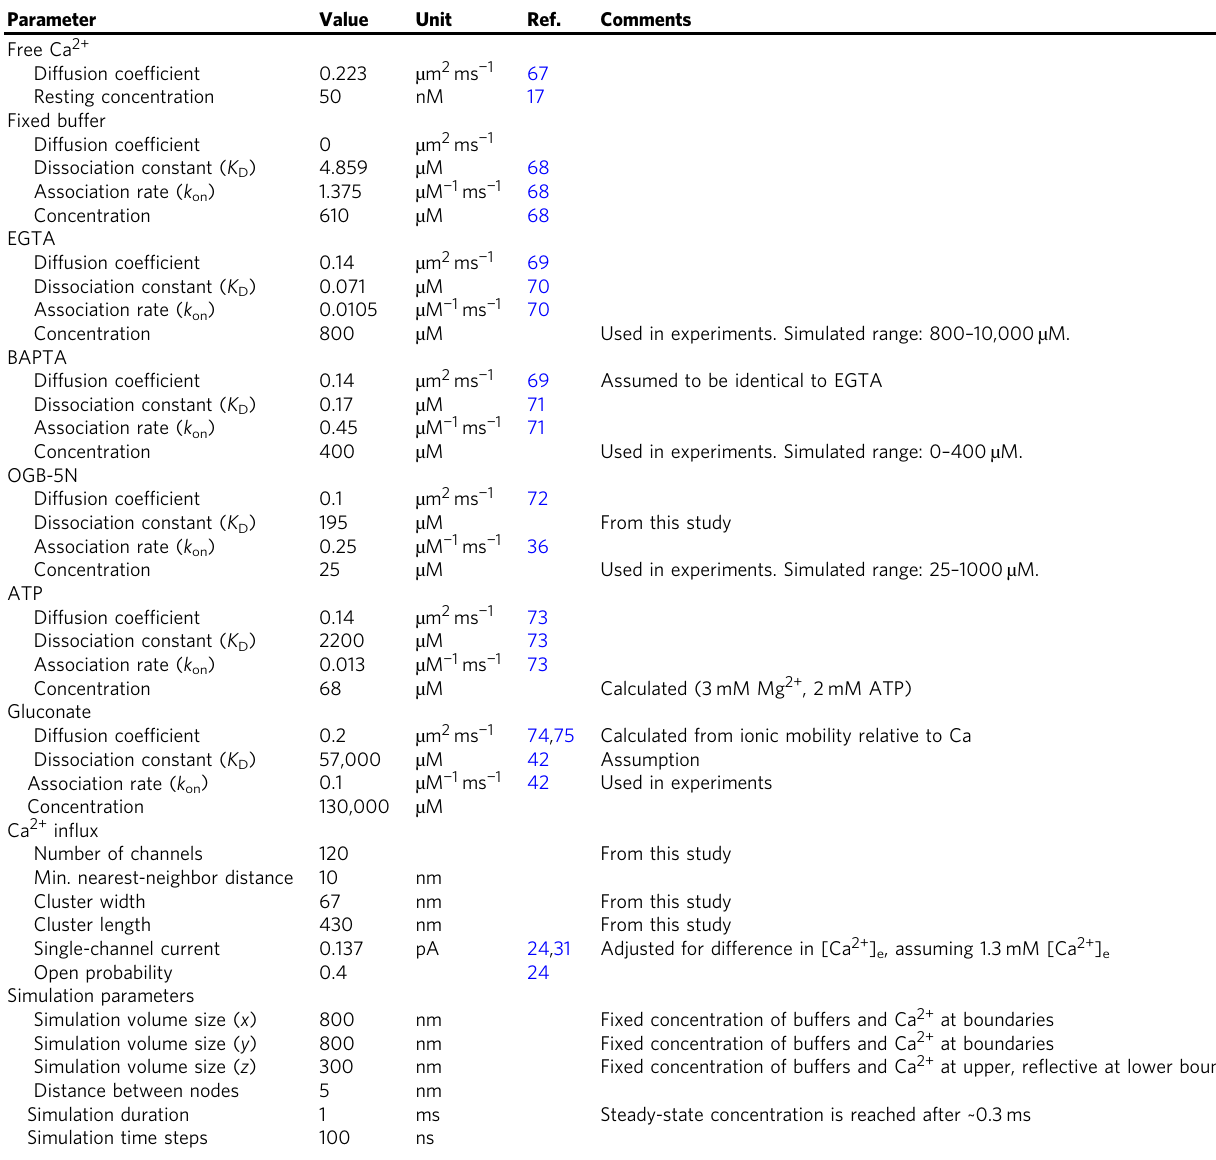
Table 1 Modeling